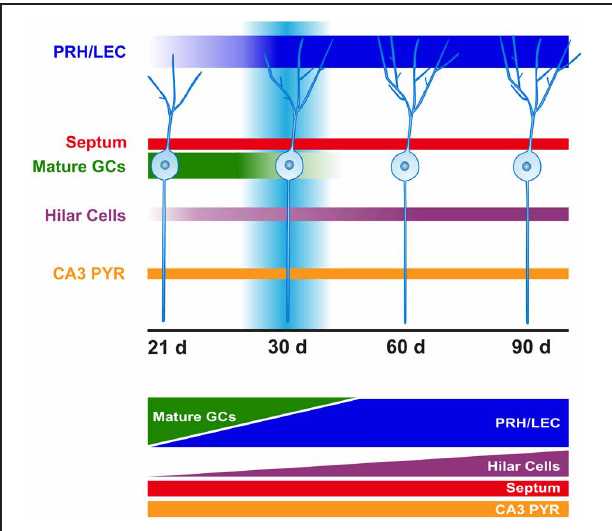
FIGURE 4 | Time course of afferent innervation of newborn GCs. Schematic representation of monosynaptic inputs to the newborn GCs at time-points evaluated (21, 30, 60, and 90 days after retroviral infection). At 21 days (d), newborn GCs mainly receive connections from mature GCs. This input gradually shifts from mature GCs to cortex following strengthening of afferents from the perirhinal (PRH) and lateral entorhinal cortex (LEC). Increased hilar cell (mossy cells and interneurons) innervation is observed over time. Convergence of excitatory afferents onto the newborn GCs around 30 days correlates with transiently enhanced new neuron excitability and plasticity. Innervation from septum and area CA3 pyramidal cells (PYR) remains constant over